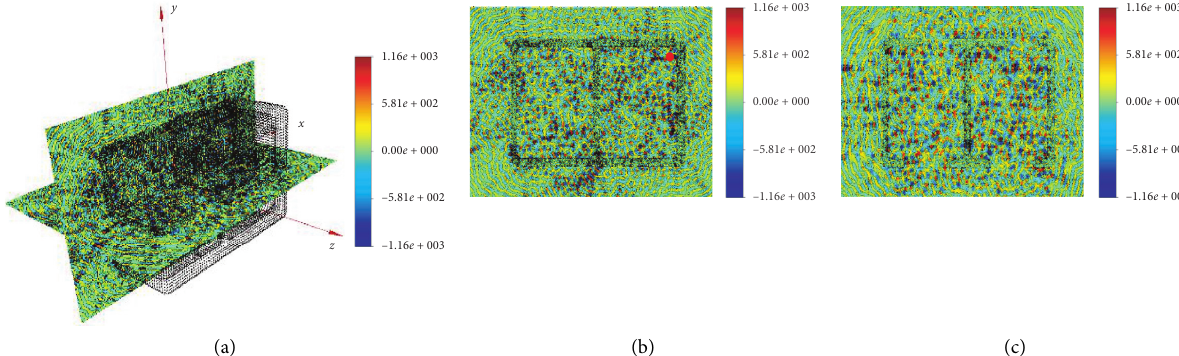
Figure 9: The isometric (a), x - y plane (b), and x - z plane (c) view of the rooms for the source location (1.2m, 0.6m, 0.7m).